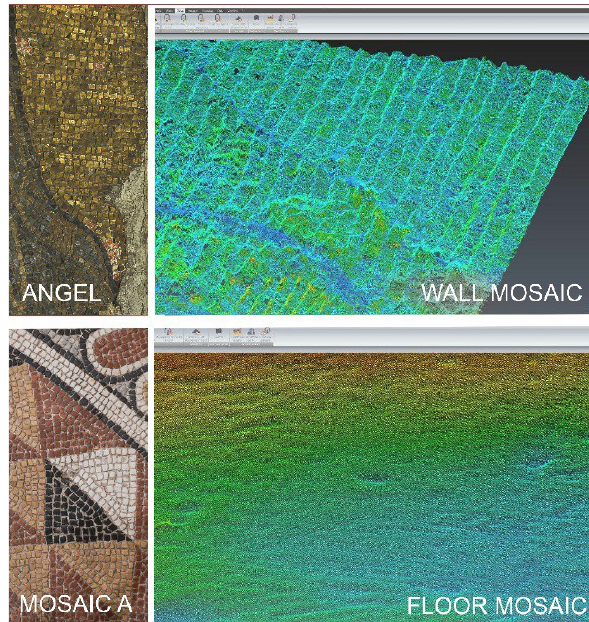
Figure 6. Images of the point cloud from TLS of mosaic A, which highlights the localized subsidence of the flooring This variation of arrangement strongly influences the visual effect of the mosaic, thanks to different light reflections that change its three-dimensional perception (Tosi, 2004).